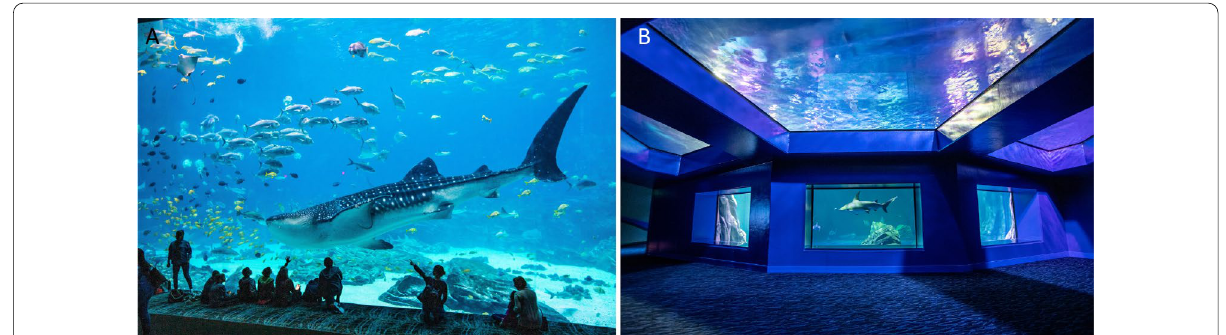
Fig. 2 Managed care of elasmobranchs in aquariums provides a unique opportunity for sampling microbiomes over time and relative to monitored host and environmental parameters. Exhibits such as Georgia Aquarium’s Ocean Voyager ( A ) and Sharks: Predators of the Deep ( B ) are enabling studies to understand the drivers of microbiome structure and its role in host health. Panel A Whale shark swimming in Georgia Aquarium’s Ocean Voyager exhibit (Chris Duncan, Georgia Aquarium). Panel B Hammerhead shark swimming in Georgia Aquarium’s Sharks: Predators of the Deep exhibit (Chris Duncan, Georgia Aquarium)